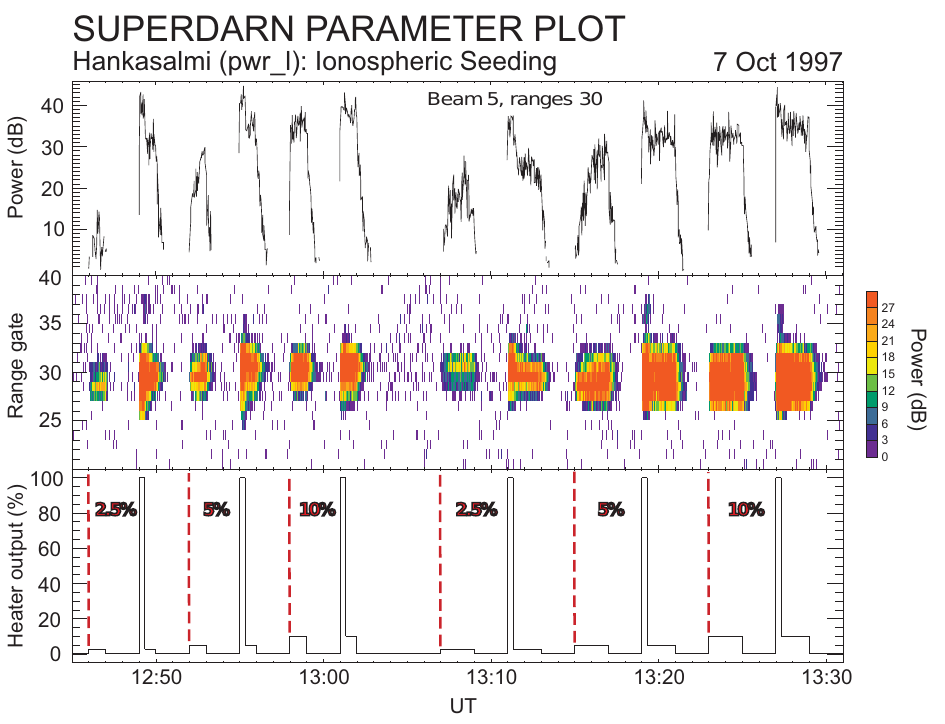
Fig. 8. The results of the ionospheric seeding experiment of 7 October 1997: The middle panel shows the backscatter power received by the Hankasalmi radar along beam 5 during heating with the Tromsø facility. Plotted in the upper panel is the backscatter power at range gate 30 along this beam. The lower panel depicts the heater output power throughout this